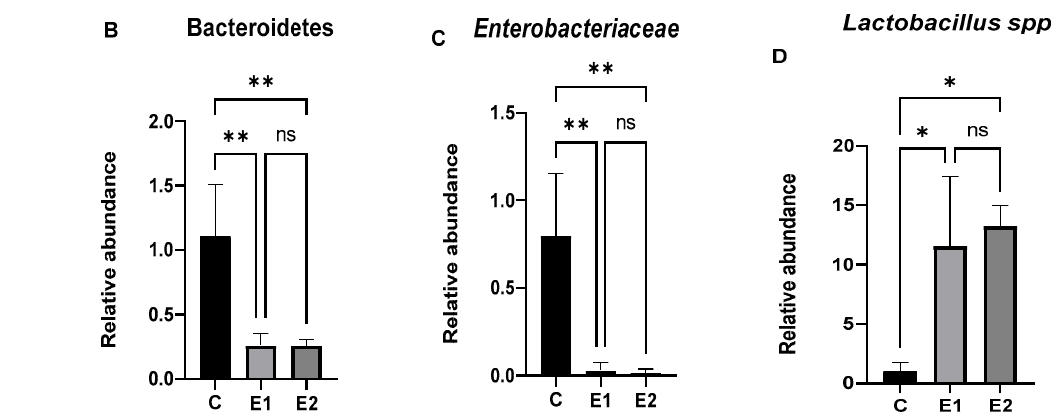
Figure 5 . The relative abundance of Firmicutes ( A ), Bacteroidetes ( B ), Enterobacteriaceae ( C ), and Lactobacillus spp. ( D ), as determined by qRT-PCR; Eubacteria 16S was used for normalization; Each column represents the relative average abundance among the treatments, ( n = 6), * p < 0.05, ** p < 0.01, (unpaired t -test). ns: none significant.